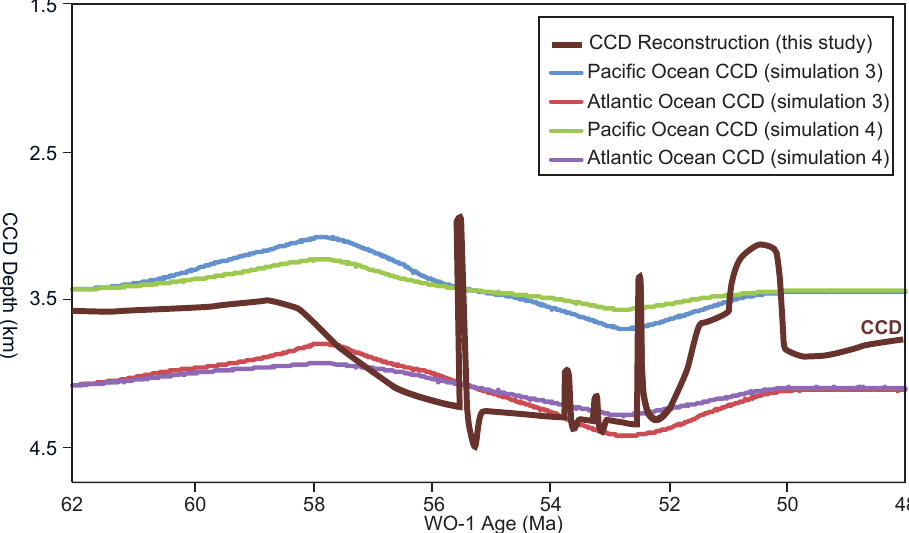
Figure 11. Comparison of data-derived CCD changes (brown, this study) to modeled CCD changes predicted for the Atlantic and Pacific oceans (green, purple, blue, and red) from 62–48Ma (Komar et al., 2013). Records and models indicate a long-term ( > 1Myr) CCD deepen- ing from 58–52Ma separated two intervals of CCD shoaling from 62 to 58Ma and 52 to 48Ma. CCD curves have different magnitudes, by several hundreds of meters, suggesting the overall carbon cycling framework is correct but with a major caveat: either mass flux variations in the modeling are too small or CCD depth constraints require additional